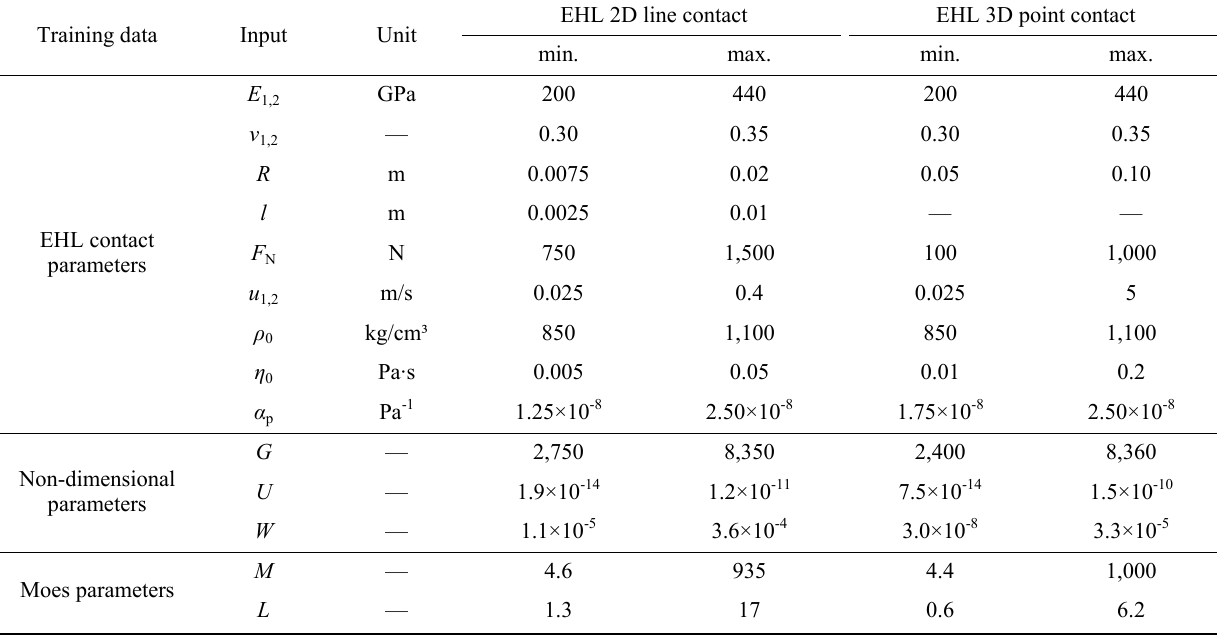
Table 3 Factor space with minima (min.) and maxima (max.) values of various inputs of infinite 2D line and 3D circular EHL point